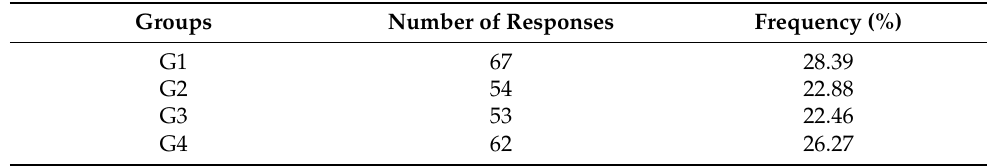
Table 6. Number of samples in different experimental groups.